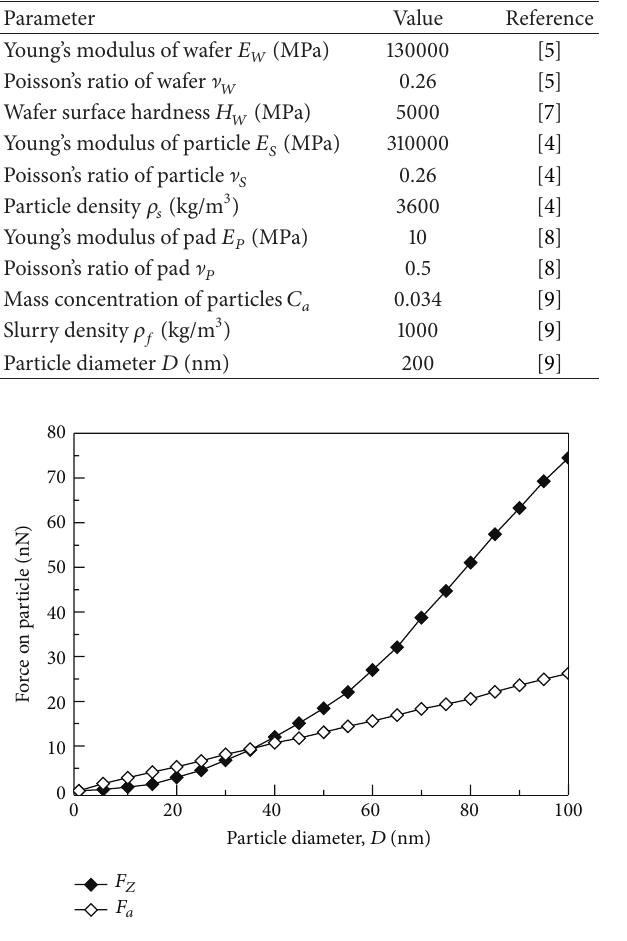
Figure 5: Comparison of 𝐹 𝑍 and 𝐹 𝑎 ( 𝐸 𝑃 = 10 MPa, 𝛿 𝑊 = 1 nm).